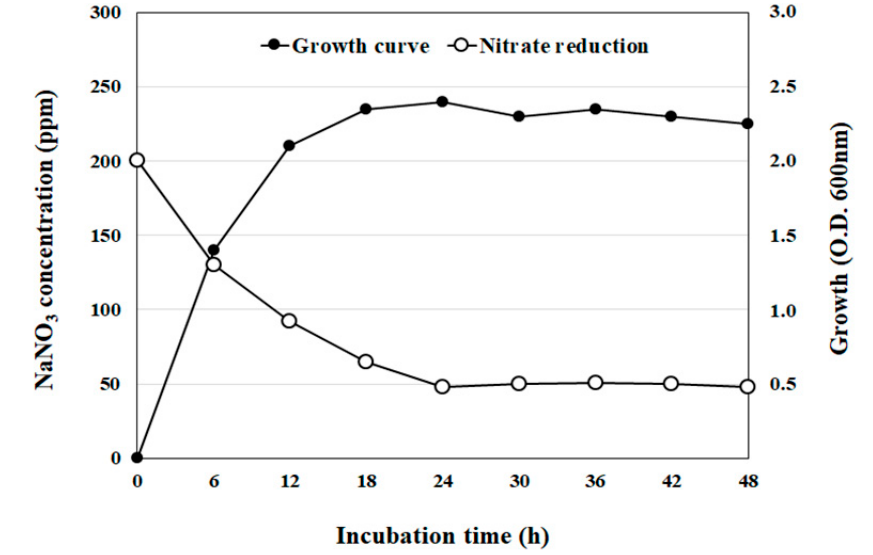
Figure 2. Bacterial growth curve and nitrate reduction by isolate LPLB5. The cells were grown at 30 °C in an MRS broth containing 200 ppm sodium nitrate (NaNO 3 ). Cell growth was determined by measuring the optical density at 600 nm. Nitrate levels in the culture supernatant were determined using a nitrate